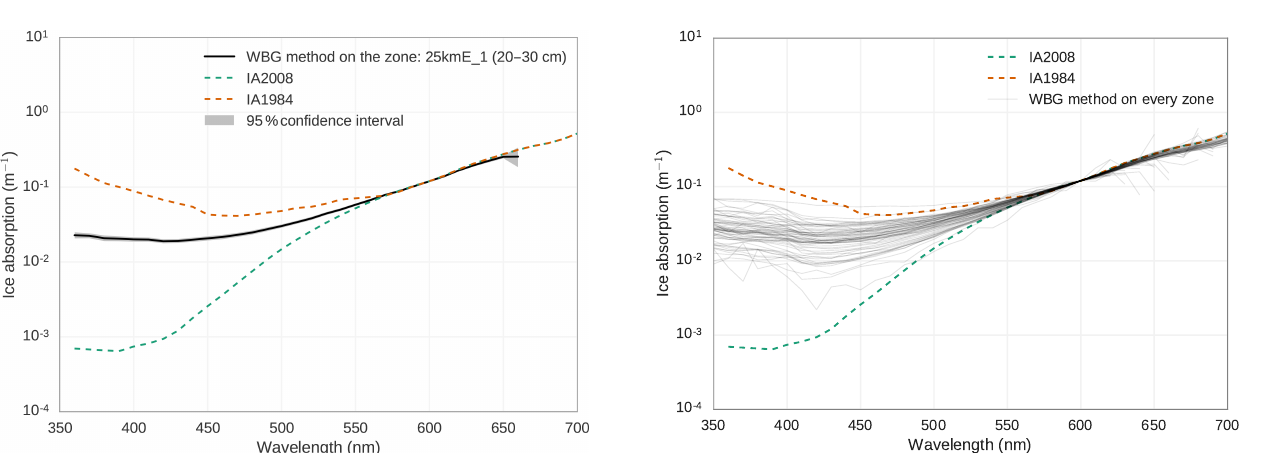
Figure 4. Ice absorption estimated by the WBG method (black) on the SOLEXS profile at 25kmE_1 (25km east of Concordia). The 95% confidence interval is shown in gray shade.